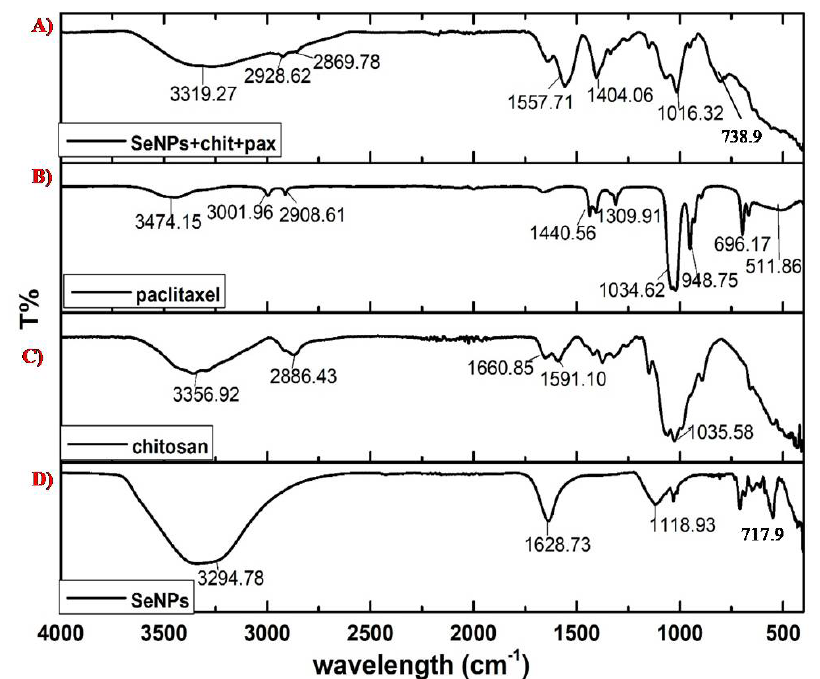
Figure 3. FTIR analysis of ( A ) SeNPs+chit+PTX, ( B ) PTX, ( C ) chitosan, and ( D ) biosynthesized SeNPs